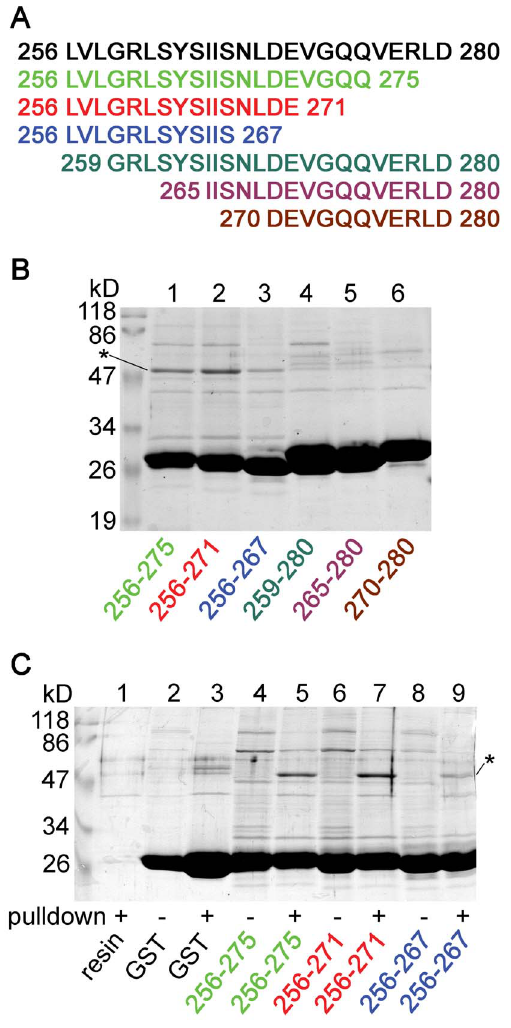
Figure 5. Fragment 256–271 of the cytoplasmic loop is sufficient for the binding of tubulin. A. The tubulin-binding fragment 256–280 of human TRESK (black, determined in the previous experiment, Fig. 4) was further truncated from the N- or the C-terminal direction as indicated by the colored sequences. B. Pull-down experiment was performed (as in Fig. 3 and 4) with the GST fusion constructs containing the sequences indicated in panel A and also below the lanes. Fragment 256–275 ( lane 1 ) and 256–271 ( lane 2 ) robustly interacted with tubulin. Tubulin was pulled down less avidly by fragment 256–267 ( lane 3 ) than by the latter two fragments, whereas the N-terminal truncations (fragments 259–280, 265–280 and 270–280, lane 4–6 ) diminished the binding of tubulin. C. Proteins from the pull- down assays were compared to the bait preparations (as in Fig. 3.C and 4.C). Note the substantial amount of tubulin binding to fragments